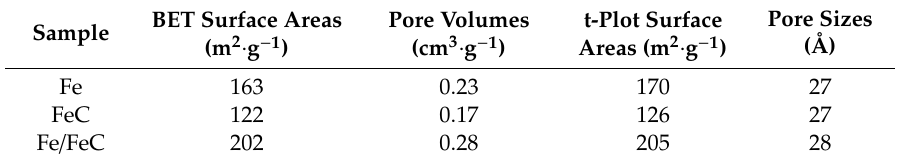
Table 1. Textural properties of the solids obtained from nitrogen adsorption–desorption isotherms.